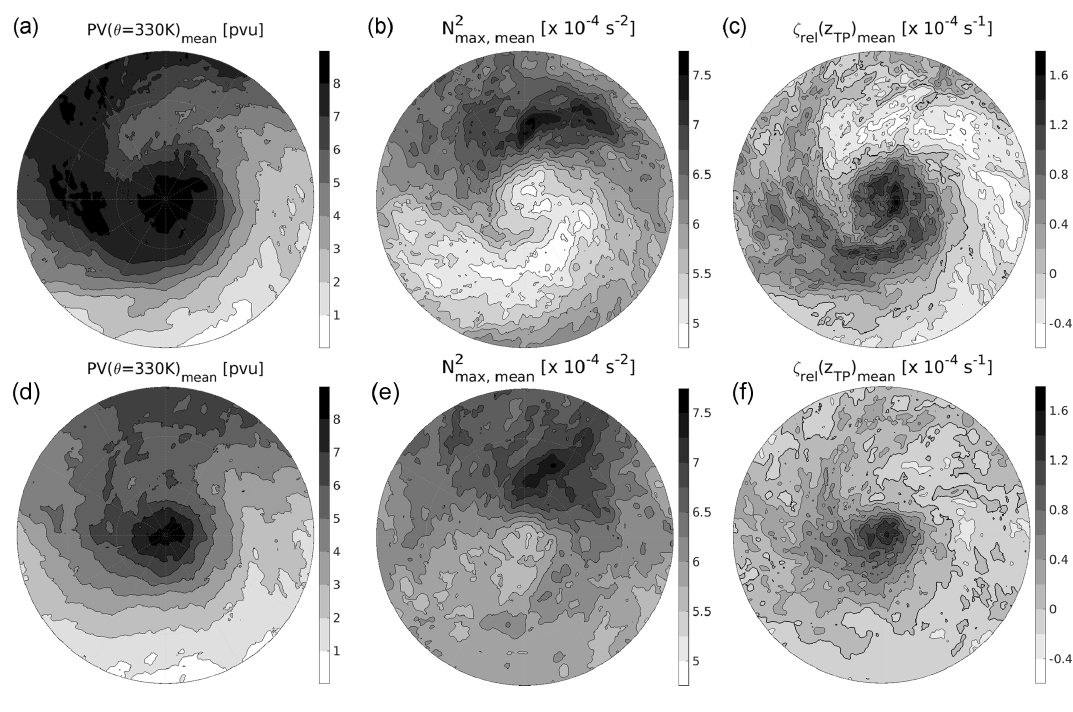
Figure 8. As in Fig. 7, but for (1) panels (a) – (c) : for the 30 very strong cyclones with p msl , min ≤ 980hPa, and (2) panels (d) – (f) : the 54 weak cyclones with p msl , min > 990hPa.